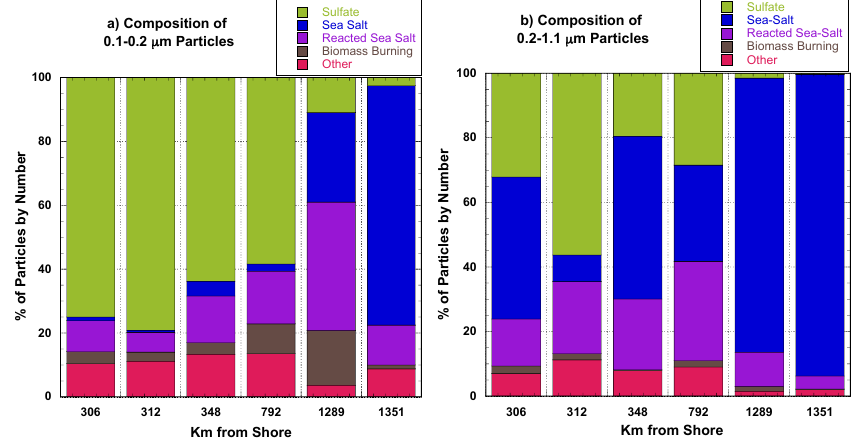
Fig. 4. Particle types by number at 150 m altitude as determined by SEM/X-ray analysis for six different samples as a function of distance west from shore. (a) Composition of smaller particles approximately 0.1 to 0.2 µm in diameter, and (b) composition of particles 0.2µm to 1.1µm in diameter. Between 819 to 1000 particles were analyzed for each sample set. “Reacted sea-salt” refers to sea-salt where chlorine has been partially or completely replaced with sulfate, nitrate or organic material, and “other” category may include soil-dust, organics, black carbon, or industrial material. Date and UTC times are, for 306km: 21 October 2008 (06:49:50 to 06:59:45, for 312km: 24